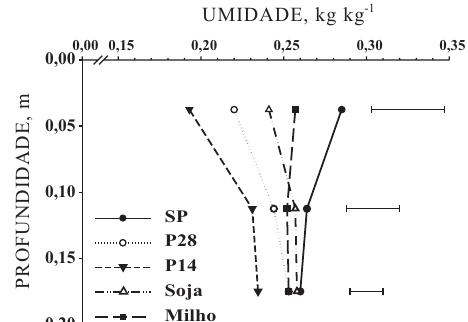
Figura 2. Umidade gravimétrica de um Argissolo Ver- melho-Amarelo alumínico sob diferentes siste- mas de manejo de uma pastagem de inverno (SP: sem pastejo; P28: pastejo a cada 28 dias; P14: pastejo a cada 14 dias). As barras horizontais correspondem à diferença mínima significativa entre os sistemas de manejo da pastagem de in- verno pelo teste de Tukey (p < 0,05).